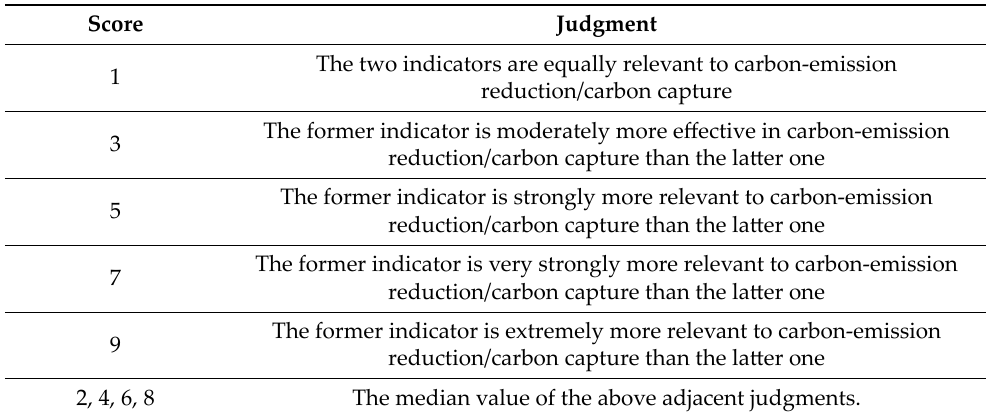
Table 7. Scoring the degree of relevance of indicators to the principles of carbon‑emission reduc‑ tion/carbon capture